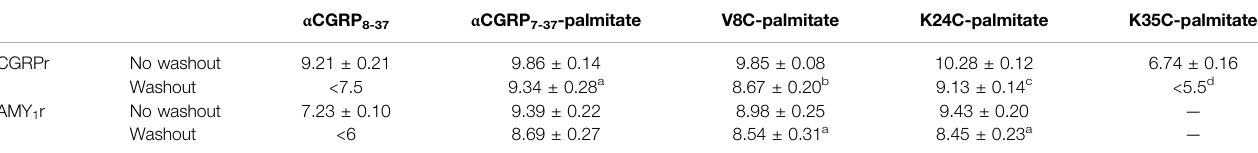
TABLE2| Effectofantagonistwithpre-incubationandawashoutsteponpA 2 valuesforlipidated α CGRP 8-37 analoguesathCGRPandhAMY 1 receptorsexpressedinCos- 7